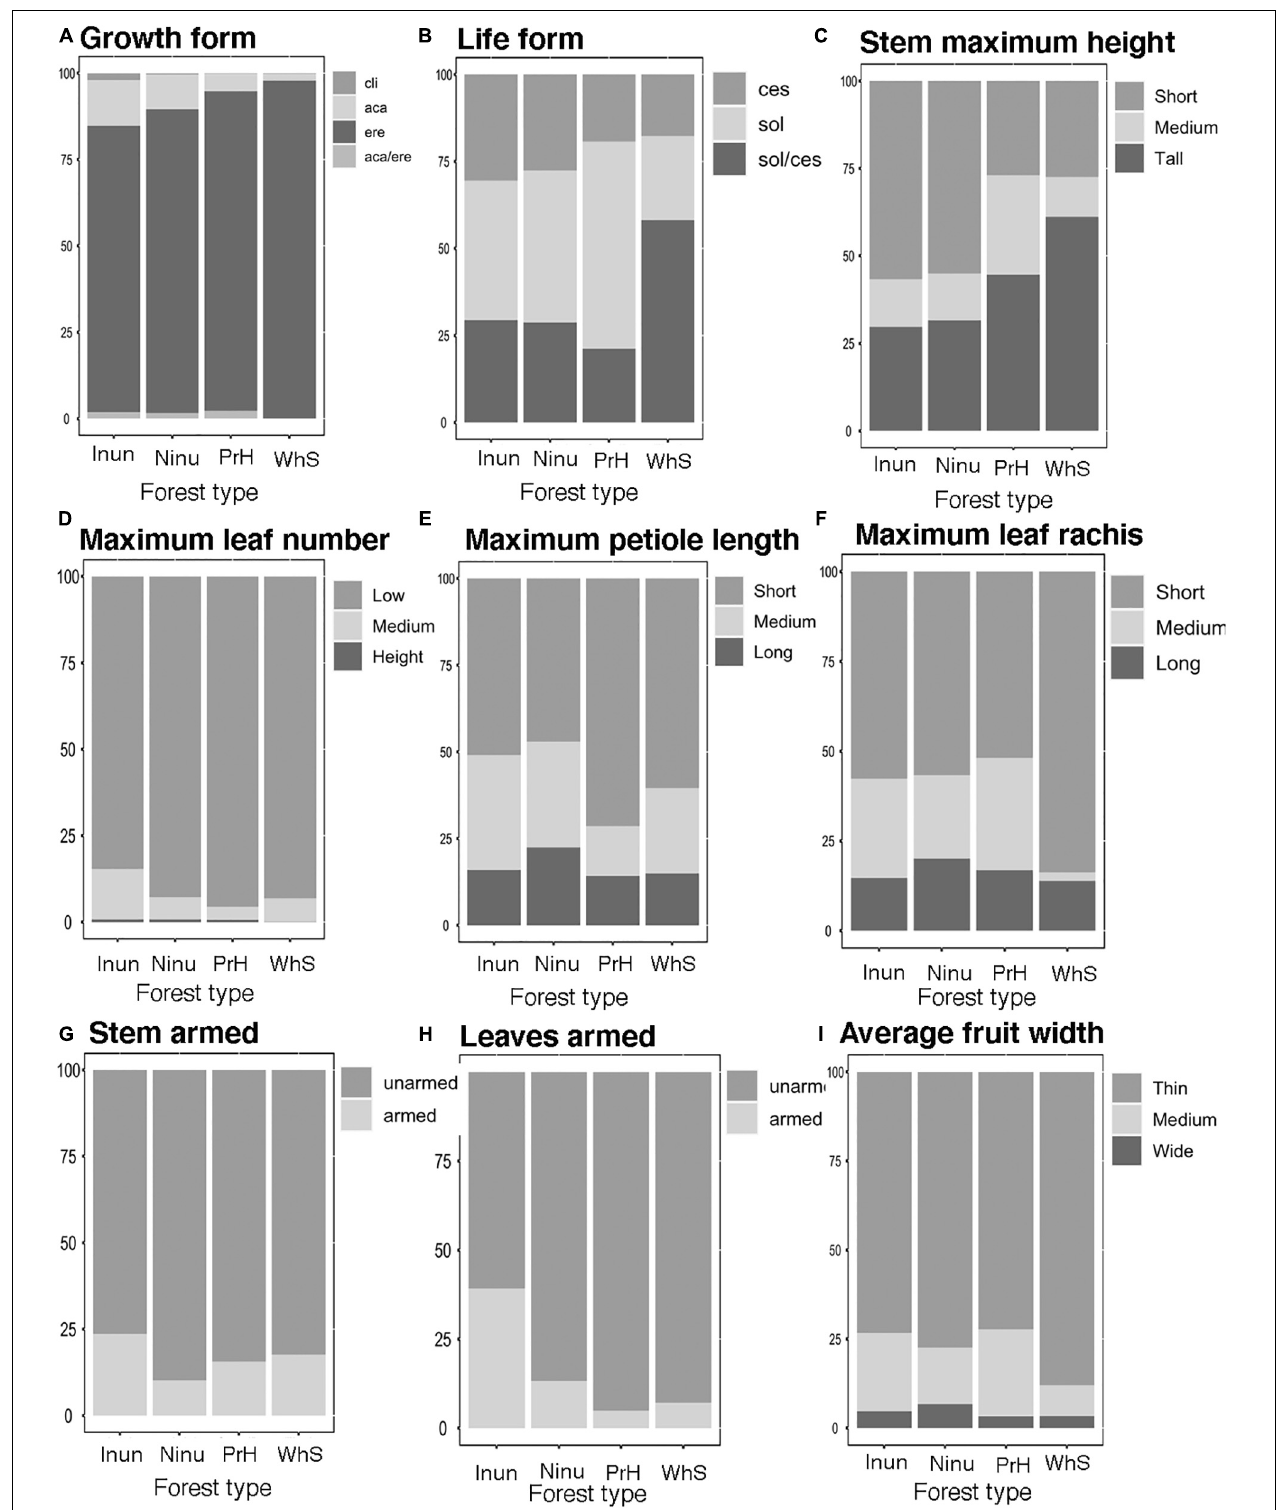
FIGURE 2 | Relative frequency distribution of functional traits in a palm community in inundated (Inun), non-inundated (Ninu), Premontane hills (PrH), and white sand (WhS) forest types along the west Amazonian. Growth forms: aca, acaulescent; ere, erect; aca/ere, both; cli, climbing. Life forms: sol, solitary; ces, cespitose; sol/ces, both. (A) Growth form, (B) Life form, (C) Stem maximum height, (D) Maximum leaf number, (E) Maximum petiole length, (F) Maximum leaf rachis, (G) Steam armed, (H) Leaves armed, and (I) Average fruit width.